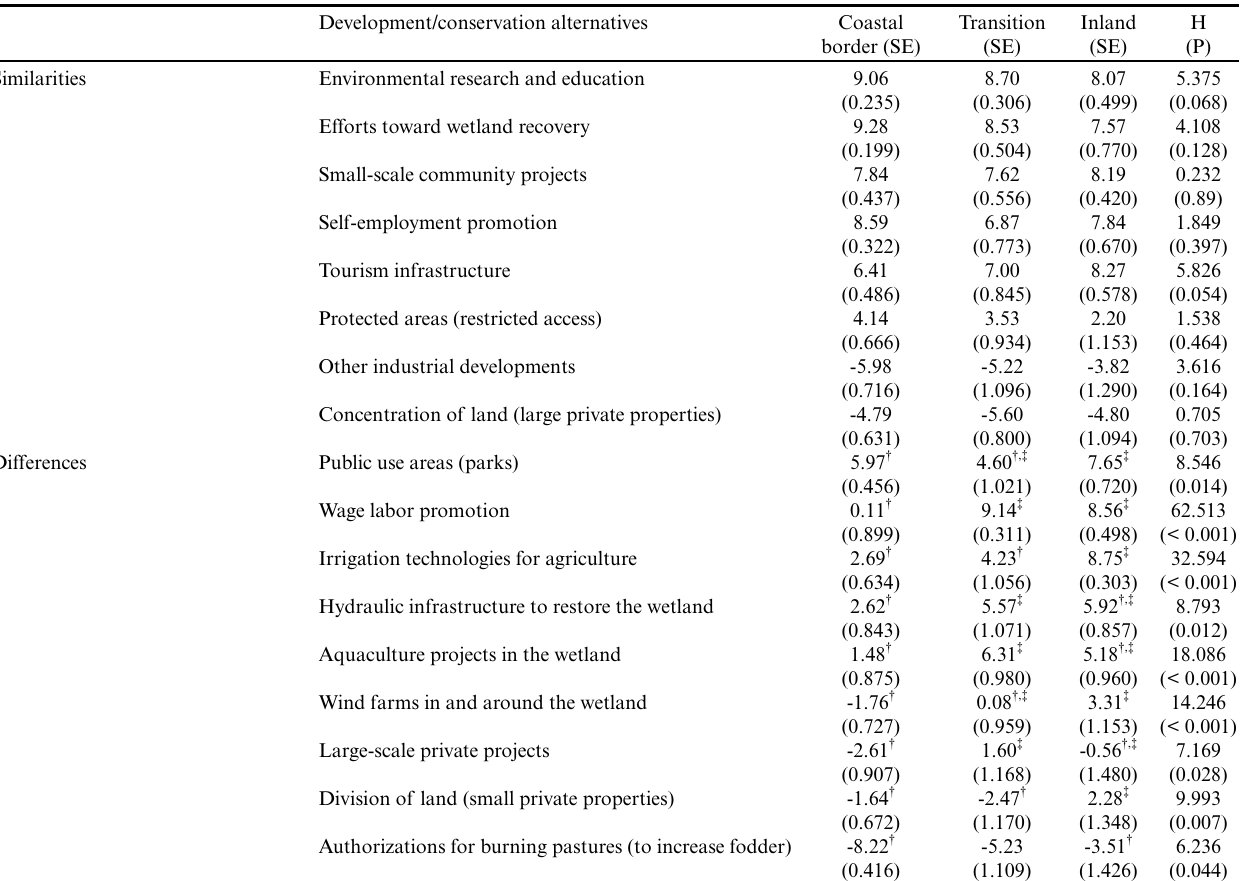
Table 3 . Similarities and differences in user groups” mean preferences for future development/conservation